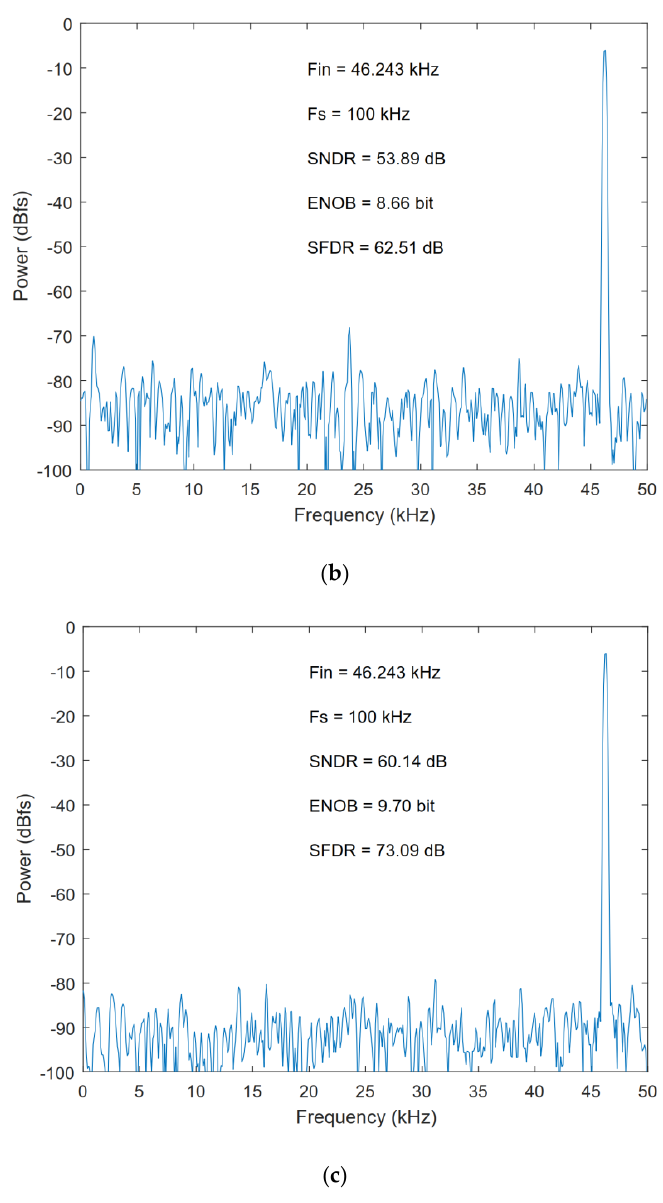
Figure 17. FFT of ADC: ( a ) 8-bit mode; ( b ) 9-bit mode; ( c ) 10-bit mode.